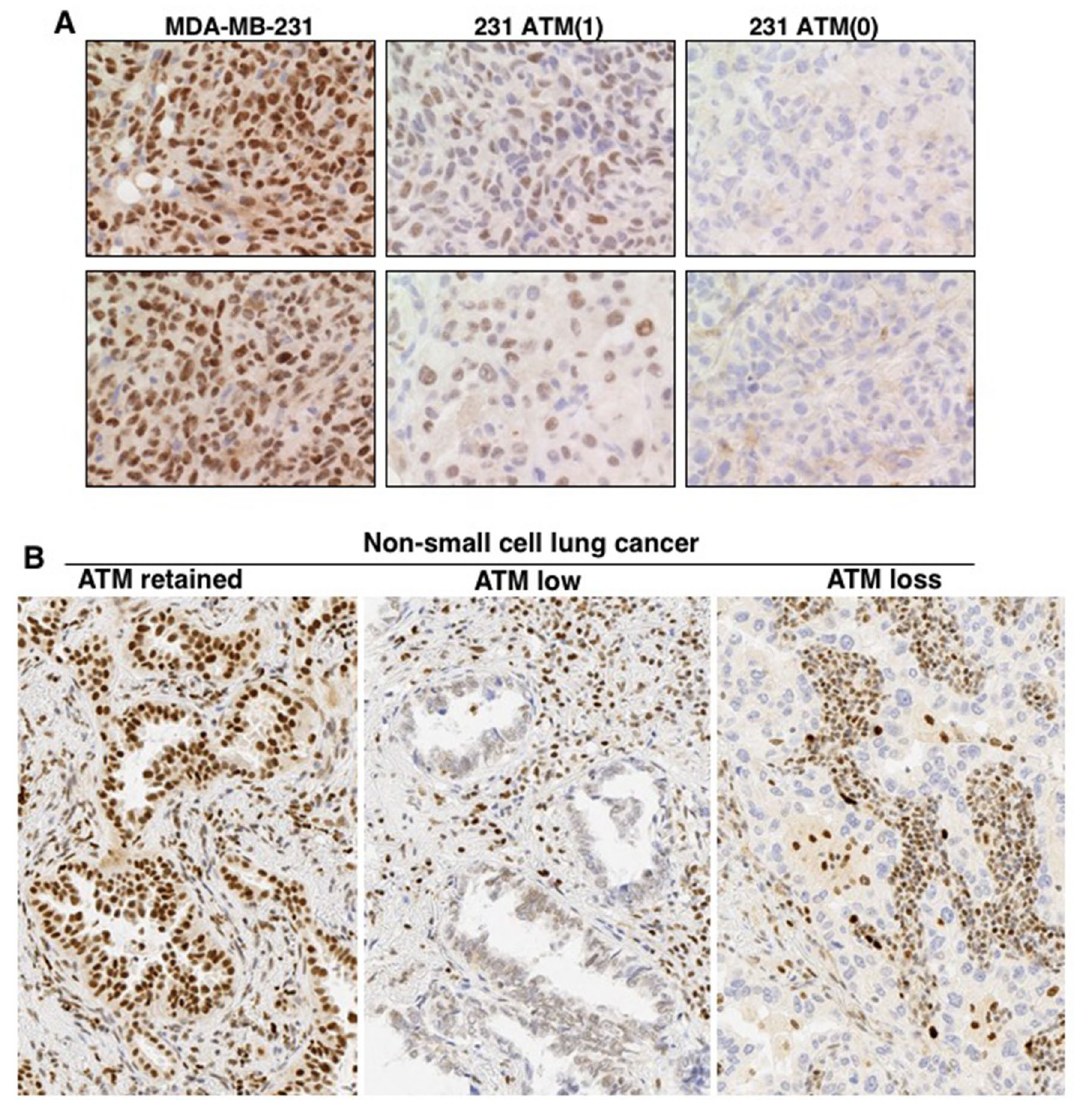
Figure 6. Immunohistochemistry of ATM in human tumor xenografts and non-small cell lung cancer. ( A ) MDA-MB-231 WT, 231 ATM(1), and 231 ATM(0) xenografts w ere generated and stained for ATM. Two fields are shown for each cell line ( B ) Non-small cell lung cancers were sectioned and stained for ATM. All fields were photographed at 20 × magnification. Representative pictures are shown for retained, low or loss expression. Each section also shows the staining of non-tumor tissue as a